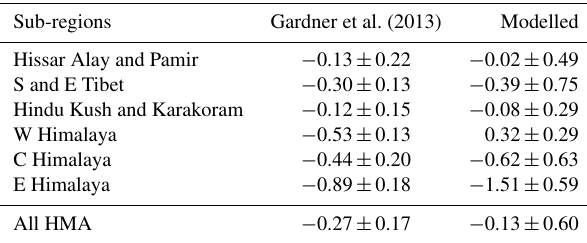
Table 4. The average rate of elevation change (myr − 1 ) for all the glaciers in sub-regions compared with remote-sensing estimates from 2003 to 2009 from Gardner et al. (2013). Sub-regions Gardner et al. (2013)